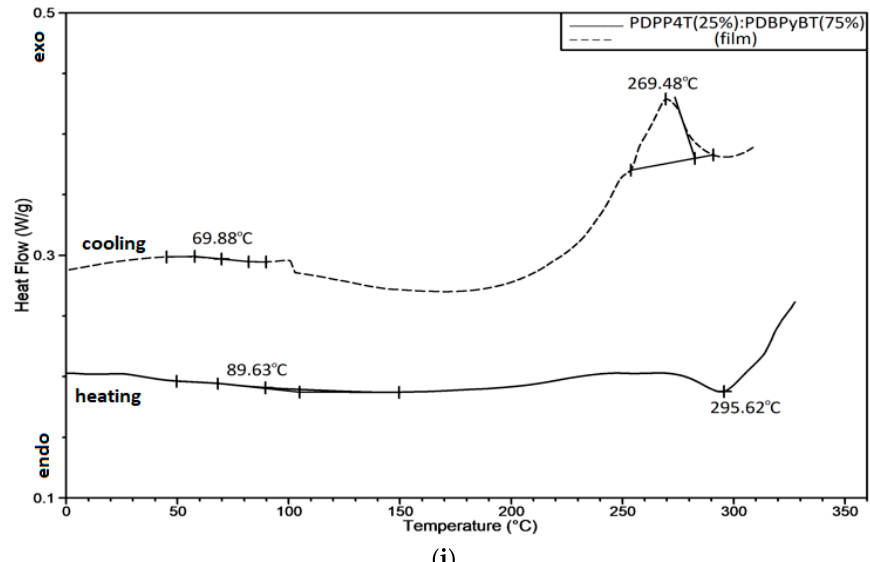
Figure 5. Ellipsometric angle Δ at 900 nm as a function of temperature and DSC plots for PDPP4T ( a , b ), PDBPyBT ( c , d ) and their blends—PDPP4T (50%):PDBPyBT (50%) ( e , f ), PDPP4T (75%):PDBPyBT (25%) ( g , h ), PDPP4T (25%):PDBPyBT (75%) ( i , j ).